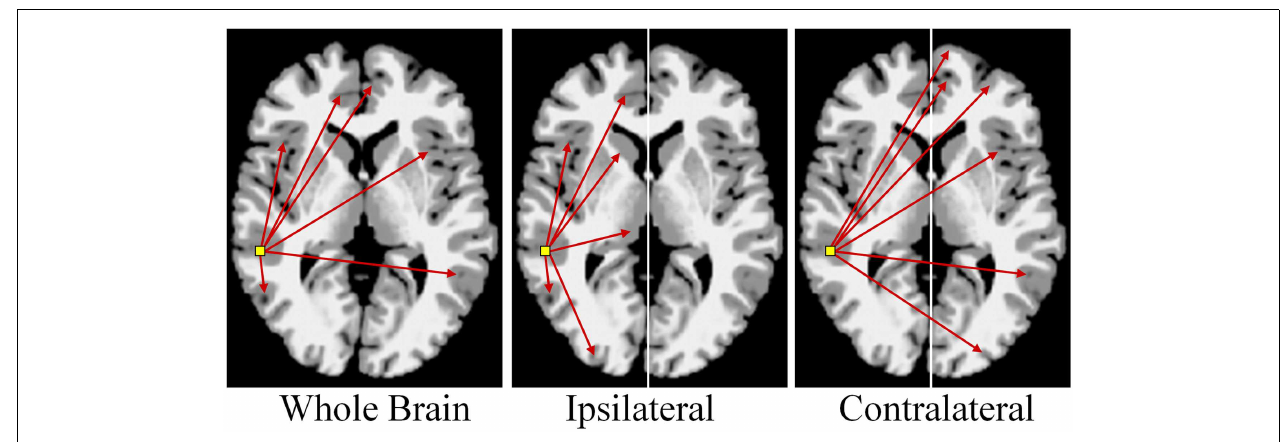
of connections to that voxel above a correlation threshold across the whole-brain (bilateral; left panel), within the same hemisphere (ipsilateral; middle panel), or to the opposite hemisphere (contralateral; right panel).